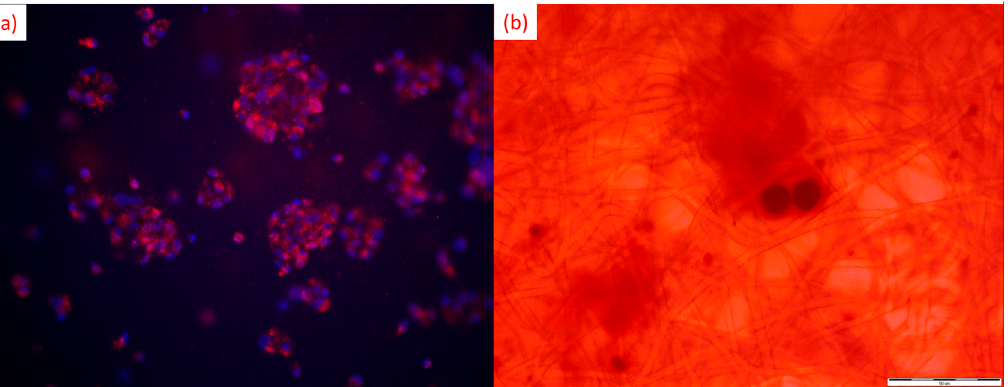
Figure 7. ( a ) Images of hDPSCs grown onto nanofiber scaffold for seven days demonstrate live hDPSCs forming colonies on PLCL surface confirmed by PKH26 red and DAPI staining (magnification ×400); ( b ) osteogenic differentiation of hDPSCs grown on PLCL stained by Alizarin Red S confirmed mineral deposits on PLCL fibers (Scale bar = 50 µm).